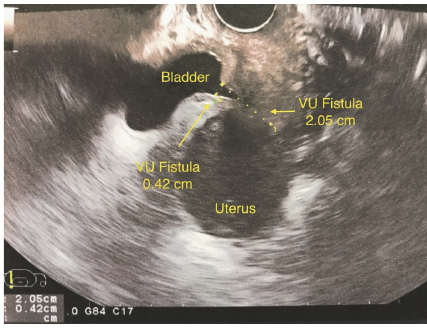
Figure 2: Transvaginal ultrasound revealing the presence of two vesicouterine fistulas.